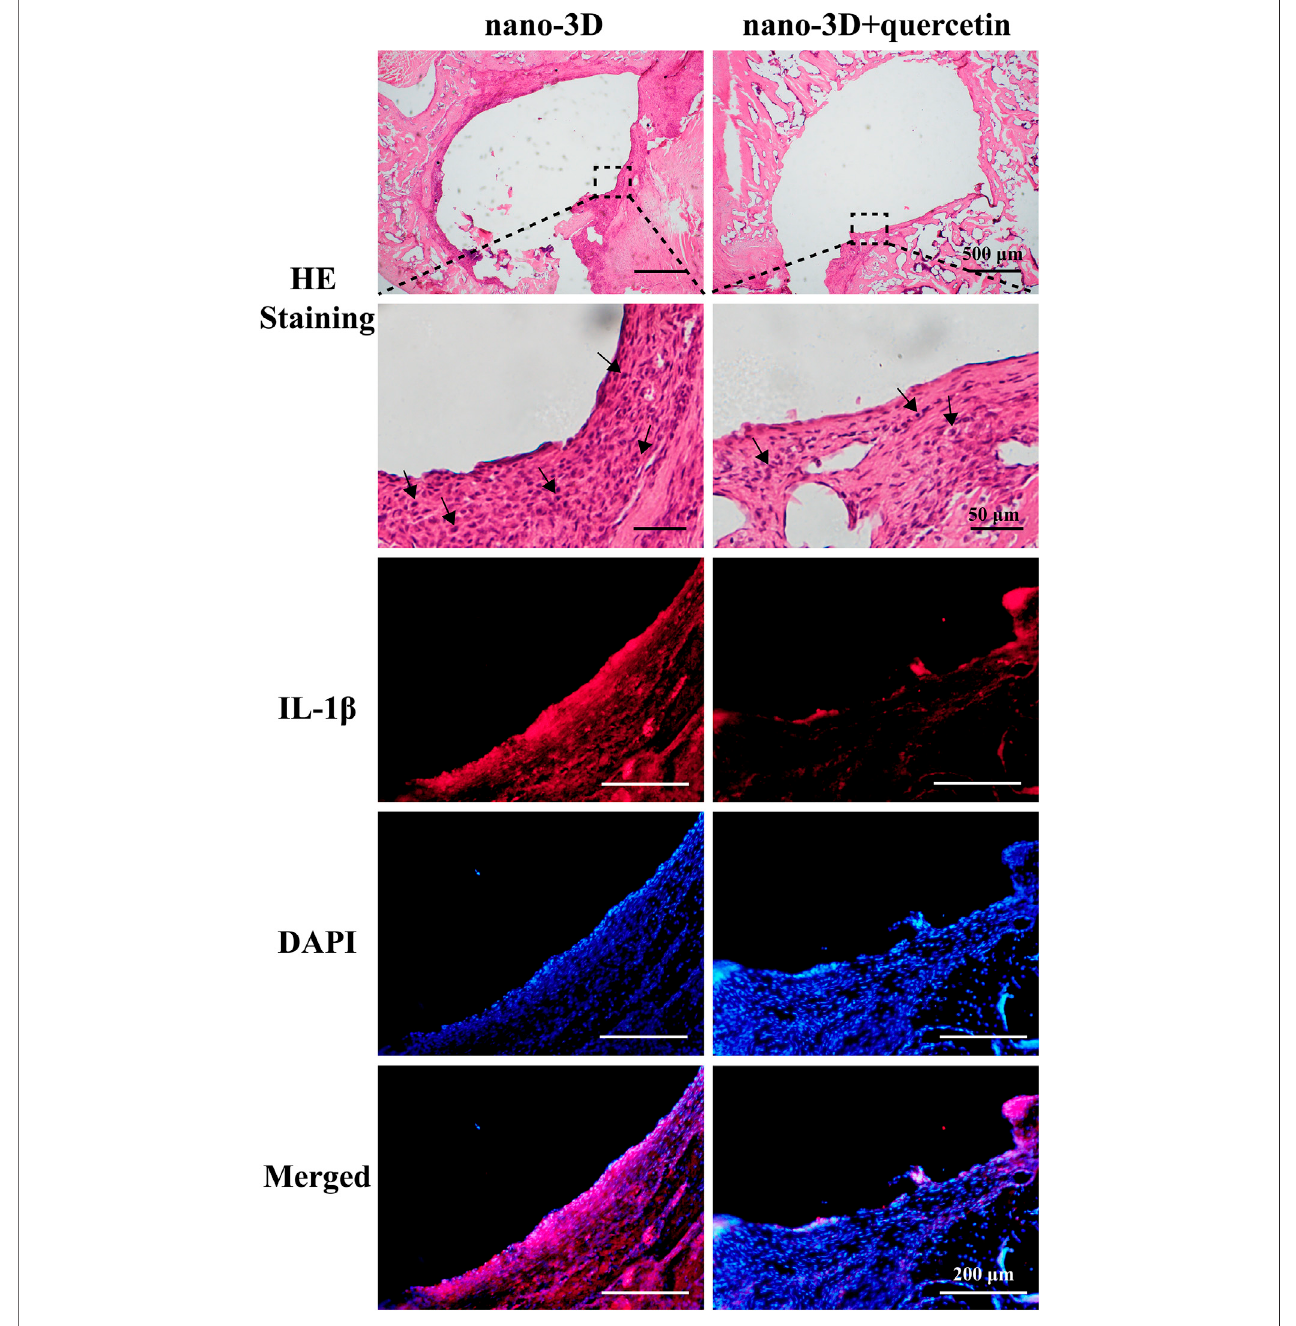
FIGURE 5 | H&E staining of the decalci fi ed peri-implant tissues of nano-3D and nano-3D + quercetin at 2 weeks, black arrows indicate in fl ammatory cells such as macrophages, neutrophils, monocytes and lymphocytes; immuno fl uorescent staining results of the decalci fi ed samples: red (IL-1 β ) and blue (DAPI).